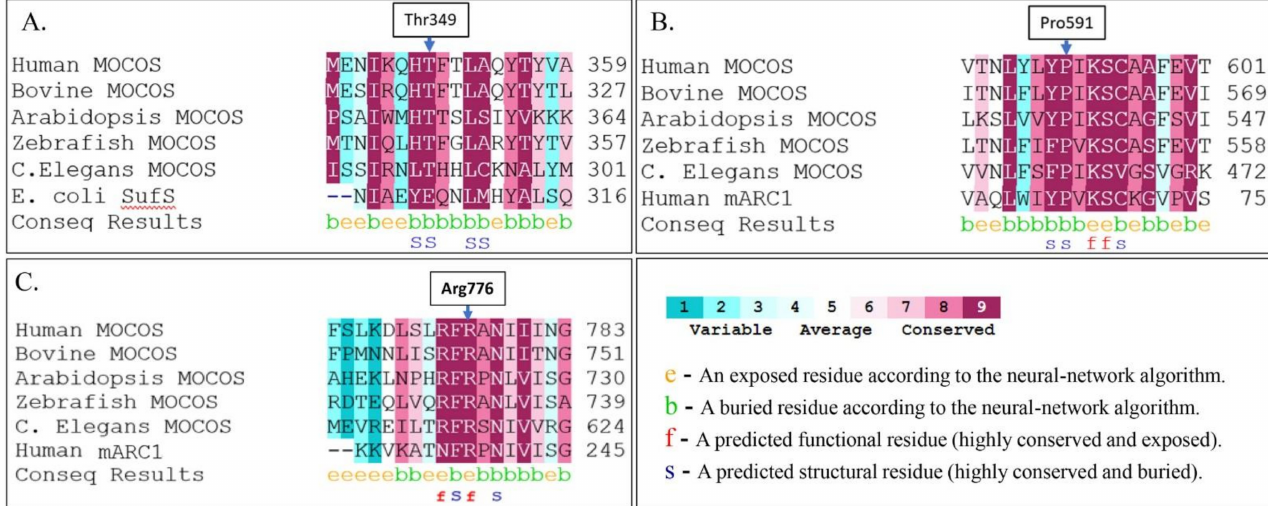
Figure 2. Evolutionary conservation of the substituted amino acid residues Thr349Ileu (panel A ), Pro591Ser (panel B ) and Arg776Cys (panel C ) in the MOCOS protein identified in patients affected by type II xanthinuria. Upon sequence comparisons across 314 PSI-BLAST hits, 294 of them were identified as unique, and conservation calculations were performed on the 150 sequences closest to human MOCOS (NP_060417.4): Bovine MOCOS NP_776506.1, Arabidopsis MOCOS Q9C5 × 8.1, Zebrafish MOCOS A2VD33, C. Elegans MOCOS Q21657, E. Coli SufS NP_416195.1 and human MTARC1 NP_073583.1. Human MTARC, i.e., human mitochondrial amidoxime reducing component, presents significant similarities along its entire length (excluding its N-terminal mitochondrial targeting sequence) to the C-terminal domain of MOCOS. Both MTARC and MOCOS proteins are members of the MOSC (Molybdenum Cofactor Sulfurase_C-terminal) domain family, with the recently solved three-dimensional structure of human MTARC1 allowing for structural comparisons between human MTARC1 and MOCOS proteins. Note that all three amino acid residues, Thr349, Pro591 and Arg776, substituted in the variant proteins are highly conserved and located within highly conserved amino acid blocks. While Thr349 and Pro591 are predicted to be buried amino acid residues, Arg776 is predicted to be exposed and